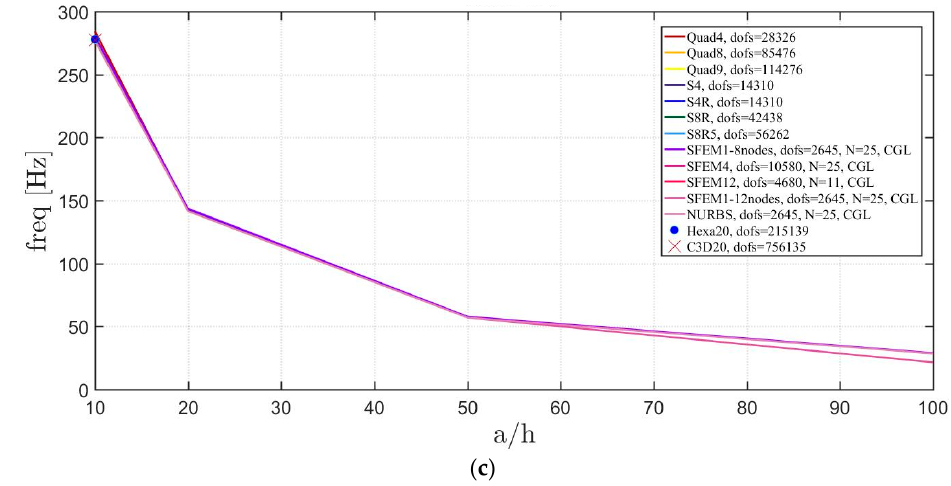
Figure 12. Thickness effect on the first three natural frequencies of an isotropic elliptic plate with a / b = 2.5: ( a ) First frequency; ( b ) Second frequency; ( c ) Third